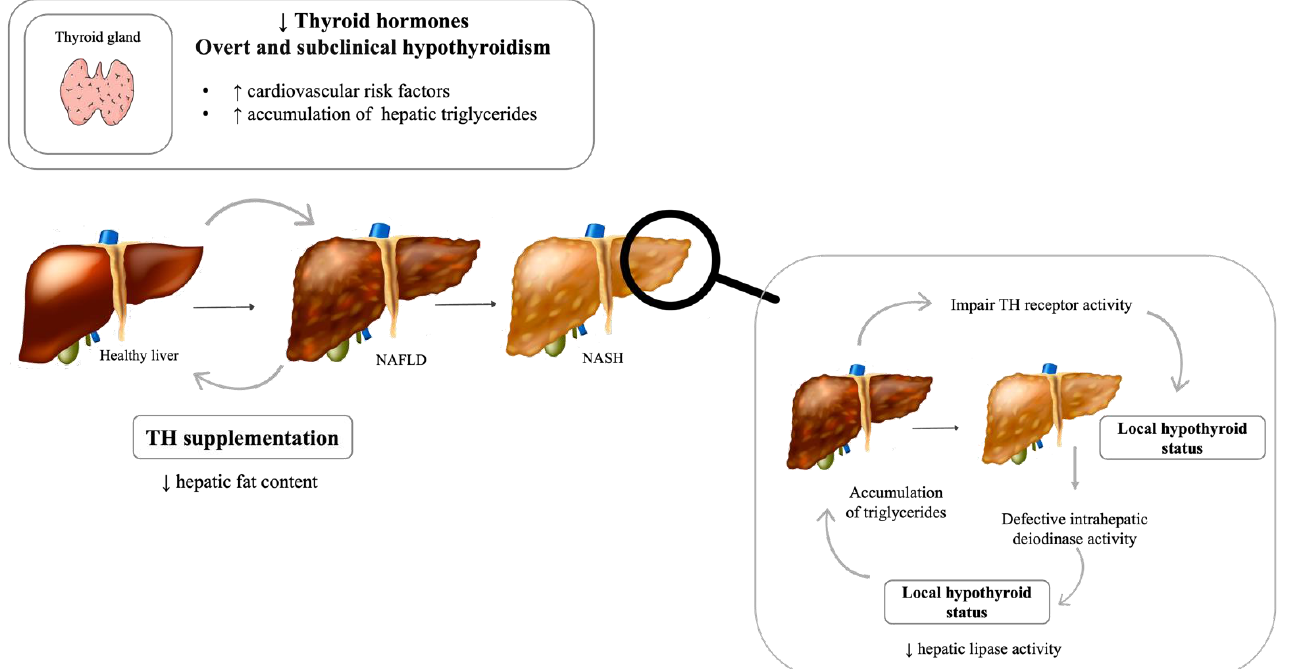
Figure 3. Thyroid – liver axis: The impact of thyroid hormones on liver. NAFLD: Nonalcoholic fatty liver disease; NASH: Nonalcoholic steatohepatitis; TH: Thyroid hormone. [Viktoriia Kasyanyuk] © 123RF.com (accessed on 22 February 2022) and Servier Medical Art by Servier. https://www.123rf.com/